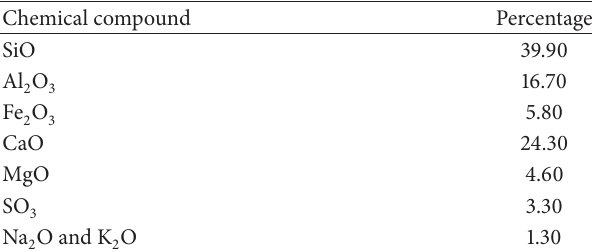
Figure 1: Particle size distribution of fine aggregate and coarse agg- regate. Table 2: Chemical composition of Class C fly ash.